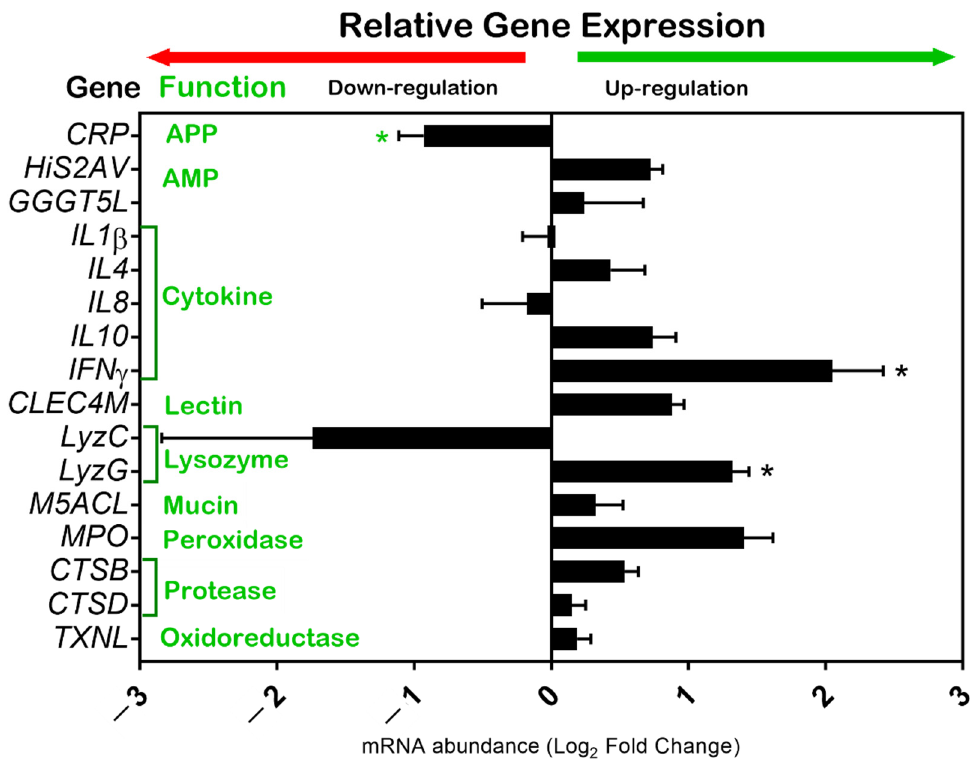
Figure 2. Immune-related gene expression signatures identified in the skin mucosa of common carp ( Cyprinus carpio ) supplemented with GOS. The Y -axis shows a list of genes (black) and enzymatic function of encoded proteins (green). Horizontal bars on the X-axis indicate the relative mRNA abundance of the genes of GOS-supplemented animals (n = 8). Gene expression analysis was carried out with RT-qPCR. qPCR reactions were performed in triplicates. The geometric mean of the 40s s11 and ACTB reference genes was used to calculate dCt values. The relative gene expression was calculated with the ddCt formula (FC = 2 – ∆∆ C t ). FC values were transformed and presented as Log 2 FC. The standard error of the means (SEM) shows the distribution of the Ct values. Normalized data (dCt values) of control and treated groups were compared with the Student’s t -test. Significant di ff erences ( p < 0.05) were labeled with an asterisk (*). Figures were prepared using GraphPad Prism 7 (GraphPad, La Jolla, CA, USA). Abbreviations used in the figure: APP—acute-phase proteins; AMP—antimicrobial